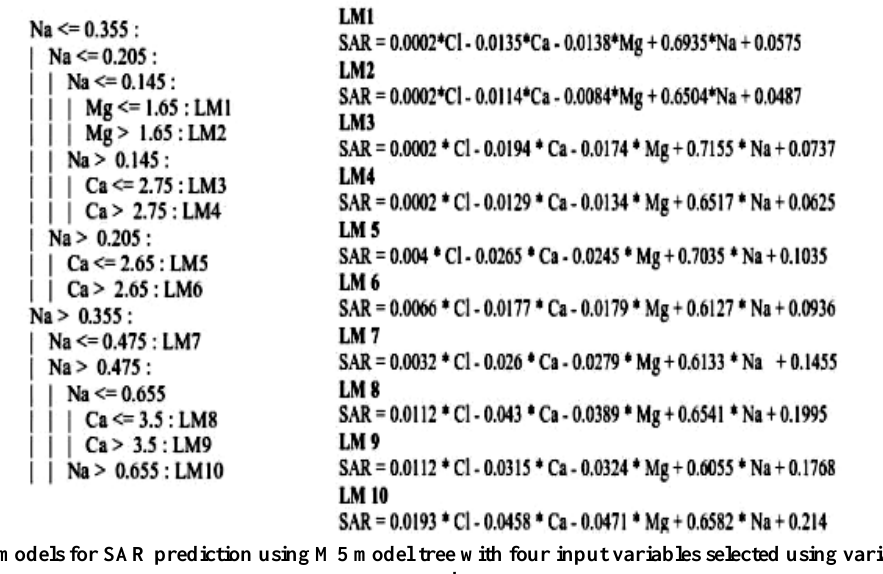
Figure 4. Linear models for SAR prediction using M5 model tree with four input variables selected using variable selection